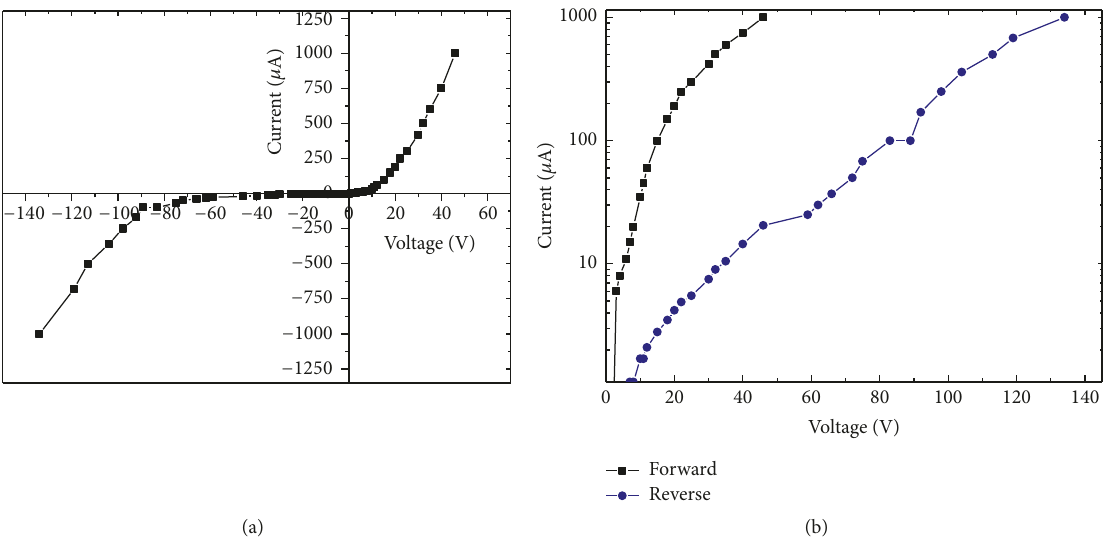
Figure 2: 𝐼 - 𝑉 characteristic of p-i-n 4 H -SiC ⟨ Al ⟩ junction, in the (a) linear and (b) semilog